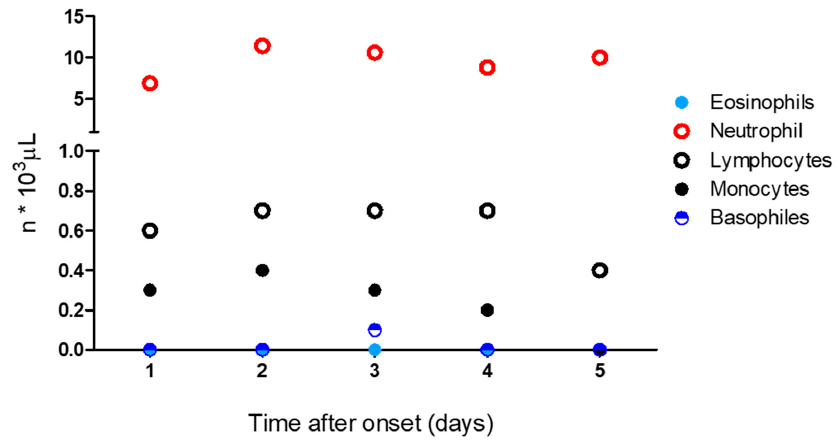
Figure 3. Timeline of the differential white cell count from admission (1 st day) to outcome (5 th day). On the first day of admission, expectorated sputum and hemoculture examinations were performed. The results from the direct microscopic examination of the expectorated sputum showed numerous S. stercoralis larvae. The larvae were elongated with a notched tail and were identified as third-stage larvae (L3). They measured from 430 to 500 µ m in length and from 14 to 16 µ m in width, with a prominent esophagus. It measured from 200 to 250 µ m. All of the measurements were performed using an optical microscope, equipped with a micrometric eyepiece (Figure 4, A–C panels). Papanicolaou staining of the sputum specimen confirmed the light microscopy observations (Figure 4, B panel).